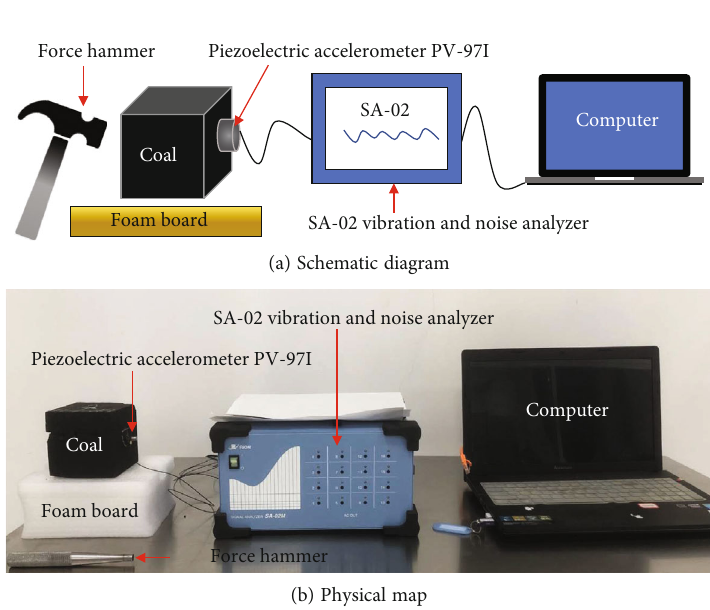
Figure 3: Testing device of coal natural